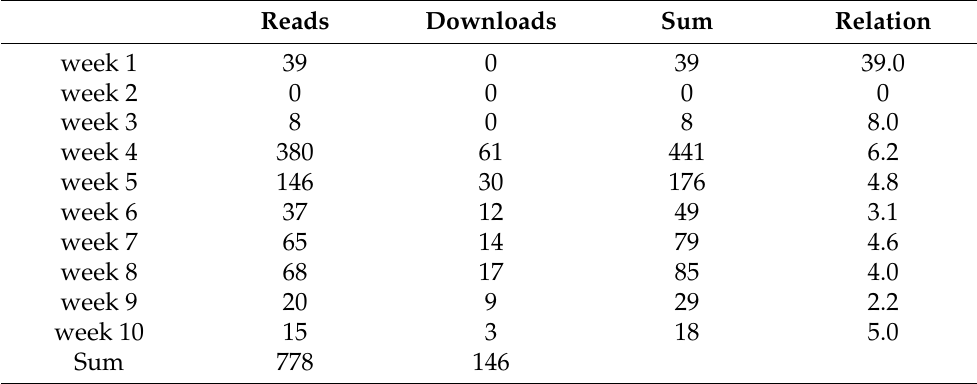
Table 1. Number of reads and downloads during the non-pandemic study period. The number of reads and downloads during the 10-week non-pandemic study period is shown on a weekly basis. The last column shows the read/download